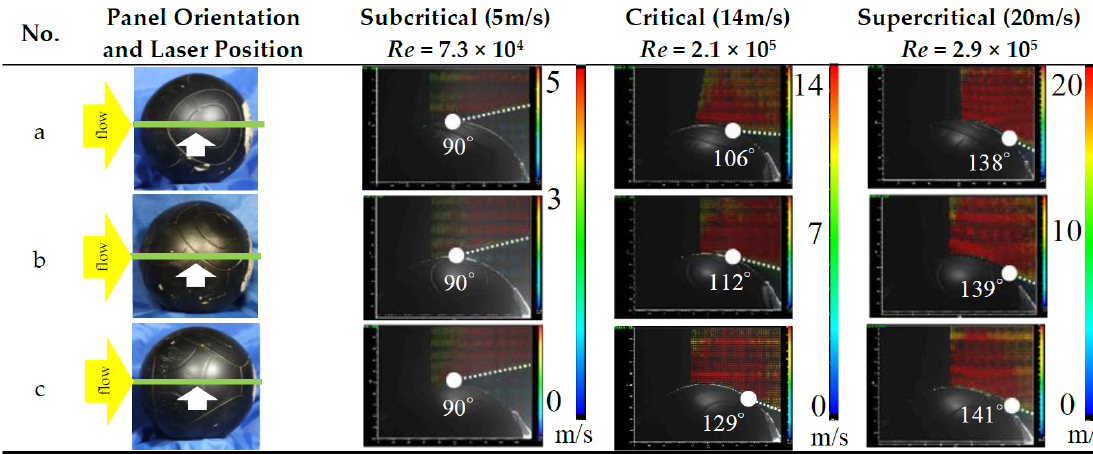
Table 4. The PIV results of Jabulani with the different panel orientations and flow